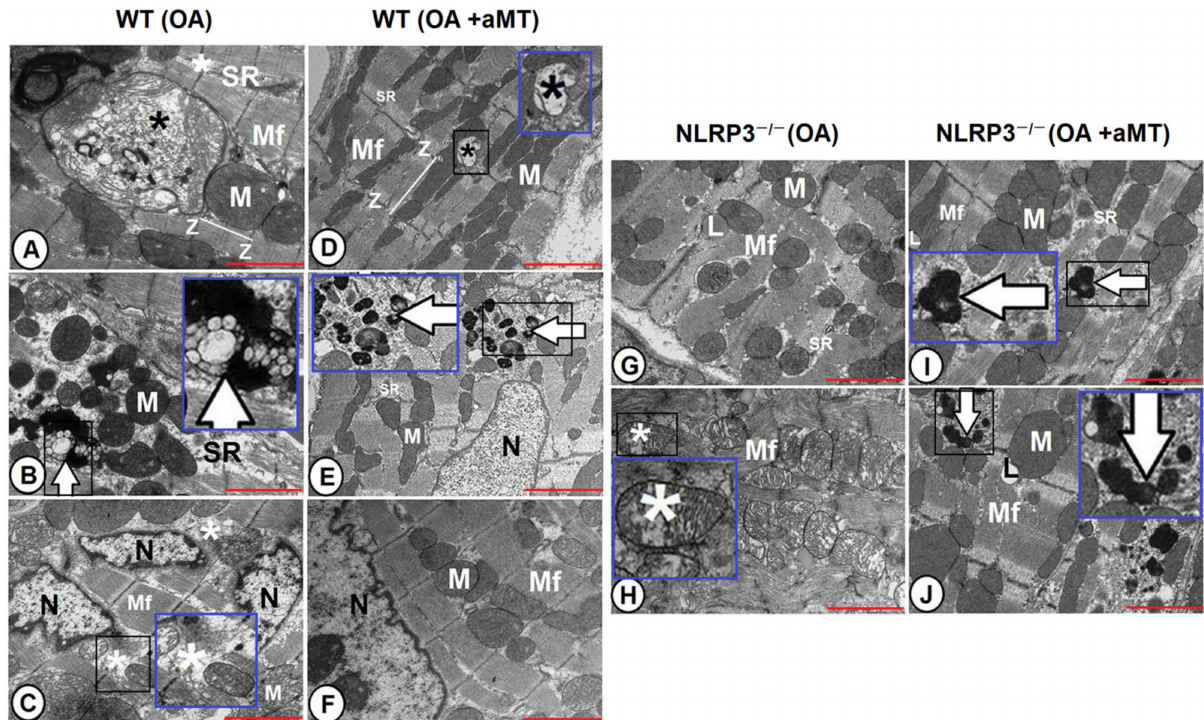
Figure 6. Effect of NLRP3 ablation and melatonin administration on age-associated ultrastructural alterations of cardiac muscle fibers. ( A – C ) Transmission electron micrographs of the LV of the OA WT mice illustrating widening of interstitial spaces (white asterisk) and disruption of the sarcoplasmic reticulum (SR) between myofibrils (Mf). Some mitochondria revealed a normal structure (M), while others were hypertrophied and demonstrated different stages of cristae damage with presence of inclusions bodies on their matrix (black asterisks). Splitting of the nucleus (N) was mostly clarified, with formation of autophagosomes (arrow). Higher magnifications of the black boxed areas in the blue insets. ( D – F ) Transmission electron micrographs of the LV of the OA WT mice after melatonin supplementation showing conservation of cardiac myofibrils (Mf), nuclear structure (N), sarcoplasmic reticulum (SR), and mitochondrial contents (M), except of individual mitochondria displayed destructed damage (black asterisk), in addition to presence of small-sized residual bodies (arrow). Higher magnifications of the black boxed areas in the blue insets. ( G , H ) Transmission electron micrographs of the LV of the OA NLRP3 − / − mice illustrating less prevalent damage of cardiac myofibrils (Mf), with well-organized sarcoplasmic reticulum (SR) and lipid droplet (L) infiltrations. Some mitochondria were normal, and intact, while others were characterized by their widely separated and organized cristae (asterisk). Higher magnification of the black boxed area in the blue inset. ( I , J ) Transmission electron micrographs of the LV of the OA NLRP3 − / − mice after treatment with melatonin depicting the maintenance of normal myofibrils (Mf) structure, sarcoplasmic reticulum (SR) organization, and mitochondrial architecture (M) during aging. Individual fibers containing residual bodies (arrows) and lipid infiltrations (L) were observed. Higher magnifications of the black boxed areas in the blue insets. Note organization of sarcomeres between each two successive Z-lines (Z). Bar “red line” = 2 µ